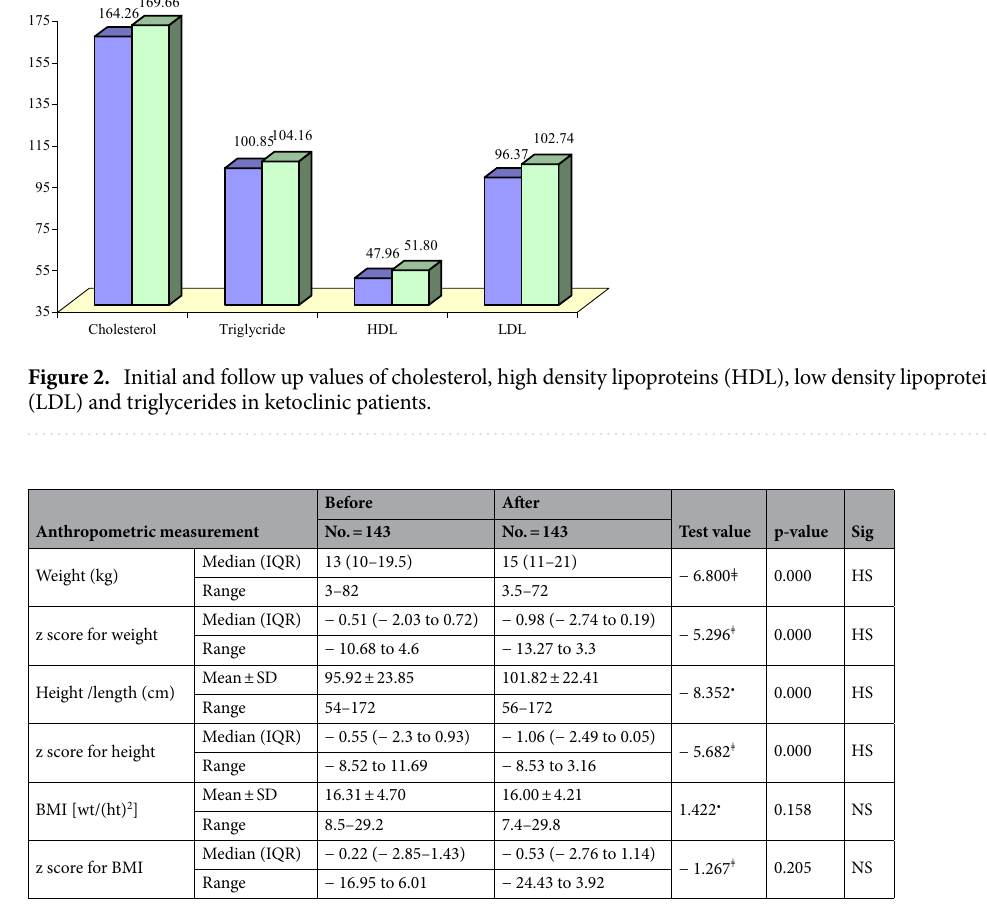
Table 4. Comparison of weight, height, BMI, z score for weight, z score for height, z score for BMI before and after KD. P-value > 0.05: Nonsignificant (NS); P-value < 0.05: Significant (S); P-value < 0.01: highly